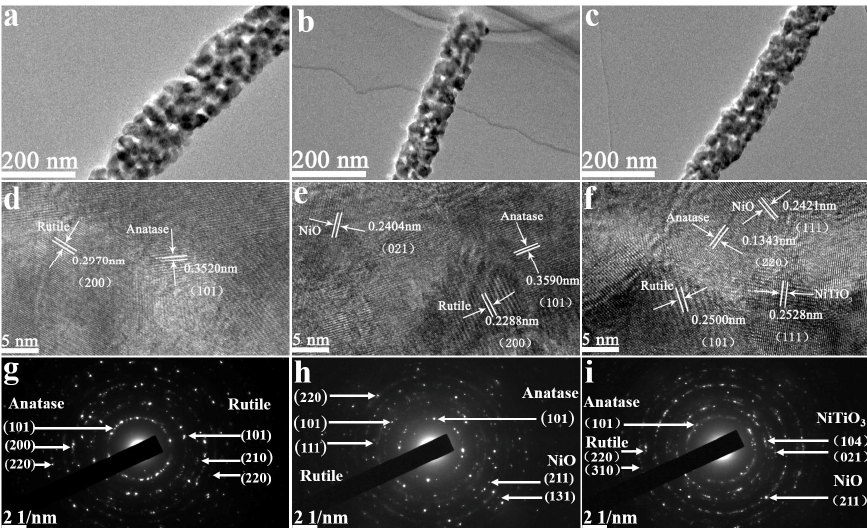
Figure 7. Transmission electron microscope (TEM) images of ( a ) pristine TiO 2 nanofibers, ( b ) 3 wt.% Ni-doped TiO 2 nanofibers, and ( c ) 6 wt.% Ni-doped TiO 2 nanofibers. HRTEM images of ( d ) pristine TiO 2 nanofibers, ( e ) 3 wt.% Ni-doped TiO 2 nanofibers, ( f ) 6 wt.%. Ni-doped TiO 2 nanofibers. SAED patterns of ( g ) pristine TiO 2 nanofibers, ( h ) 3 wt.% Ni-doped TiO 2 nanofibers, and ( i ) 6 wt.% Ni-doped TiO 2 nanofibers.